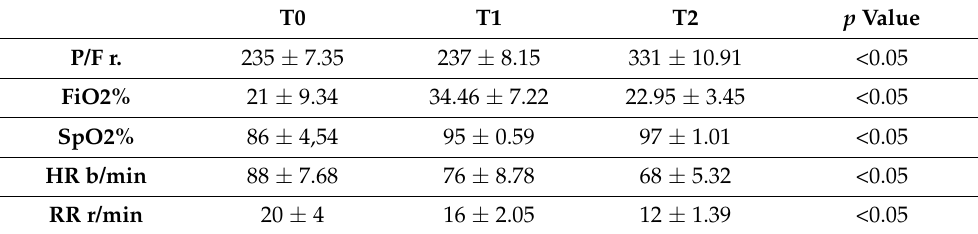
Table 2. Respiratory function